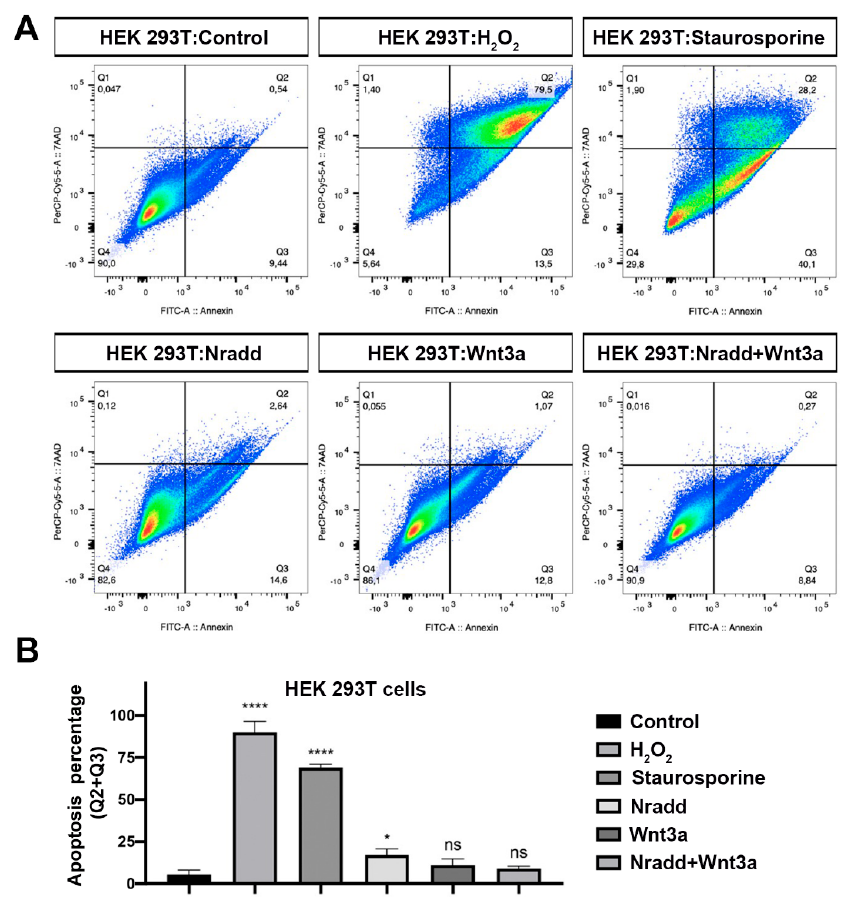
Figure 6. Zebrafish Nradd promotes apoptosis in human embryonic kidney cells. ( A ) Apoptosis assay on HEK293T cells using flow cytometry after staining with annexin V-FITC and 7AAD. Representative scatter plots of 7AAD (y-axis) vs. annexin V-FITC (x-axis). Nradd significantly enhances apoptosis. ( B ) Percentage of apoptotic cells, * indicates p < 0.05, **** is p < 0.0001 and ns is non-significant. All experiments were performed in five replicates. Three independent experiments were conducted.